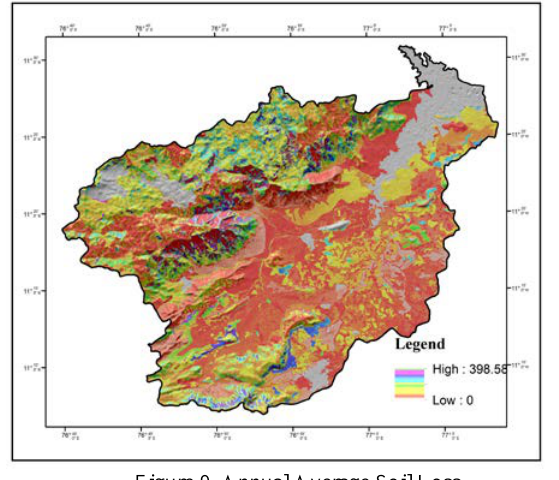
Figure 9. Annual Average Soil Loss